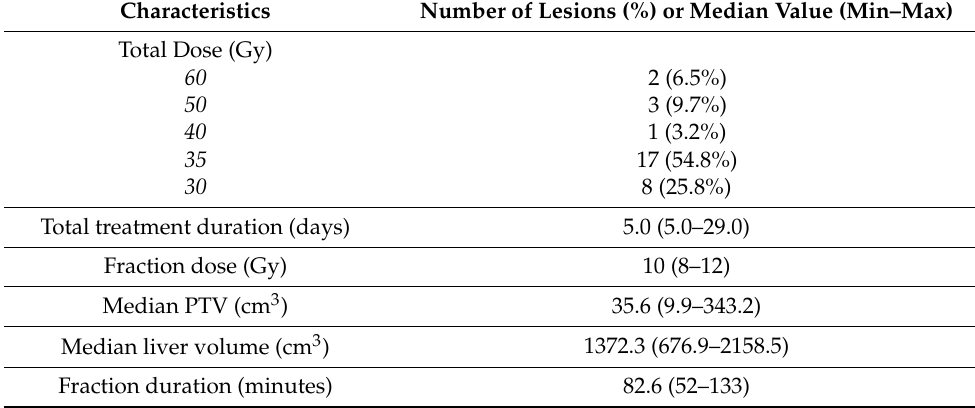
Figure 1. ( A , B ) Typical MRgRT dosimetry for liver metastases. ( A ): Example of dosimetry for a liver metastasis from breast cancer. We performed an adaptive process because of the proximity of the heart (in orange). PTV in blue colorwash. Isodose lines: 63 Gy in yellow, 57 Gy in green, 40 Gy in pink, 30 Gy in red, 25 Gy in blue, 20 Gy in cyan. Abbreviation: Gy = gray ( B ): Example of dosimetry for a liver metastasis from colorectal cancer. We performed an adaptive process because of the proximity of the heart (in pink) and stomach (in light blue). PTV in purple colorwash. Isodose lines: 47.5 Gy in green, 40 Gy in pink, 30 Gy in red, 25 Gy in blue, 20 Gy in cyan. Abbreviation: Gy = gray. Table 2. Dosimetric data for initial